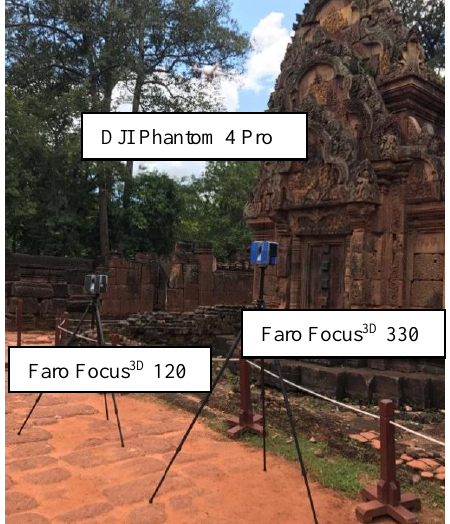
Figure 2. The sensors used for the 3D documentation project